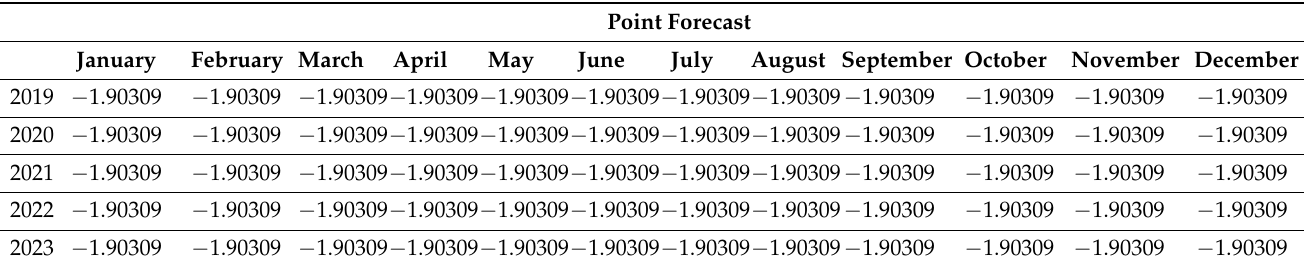
Table 19. Point forecasted value of SPEI-24 for five